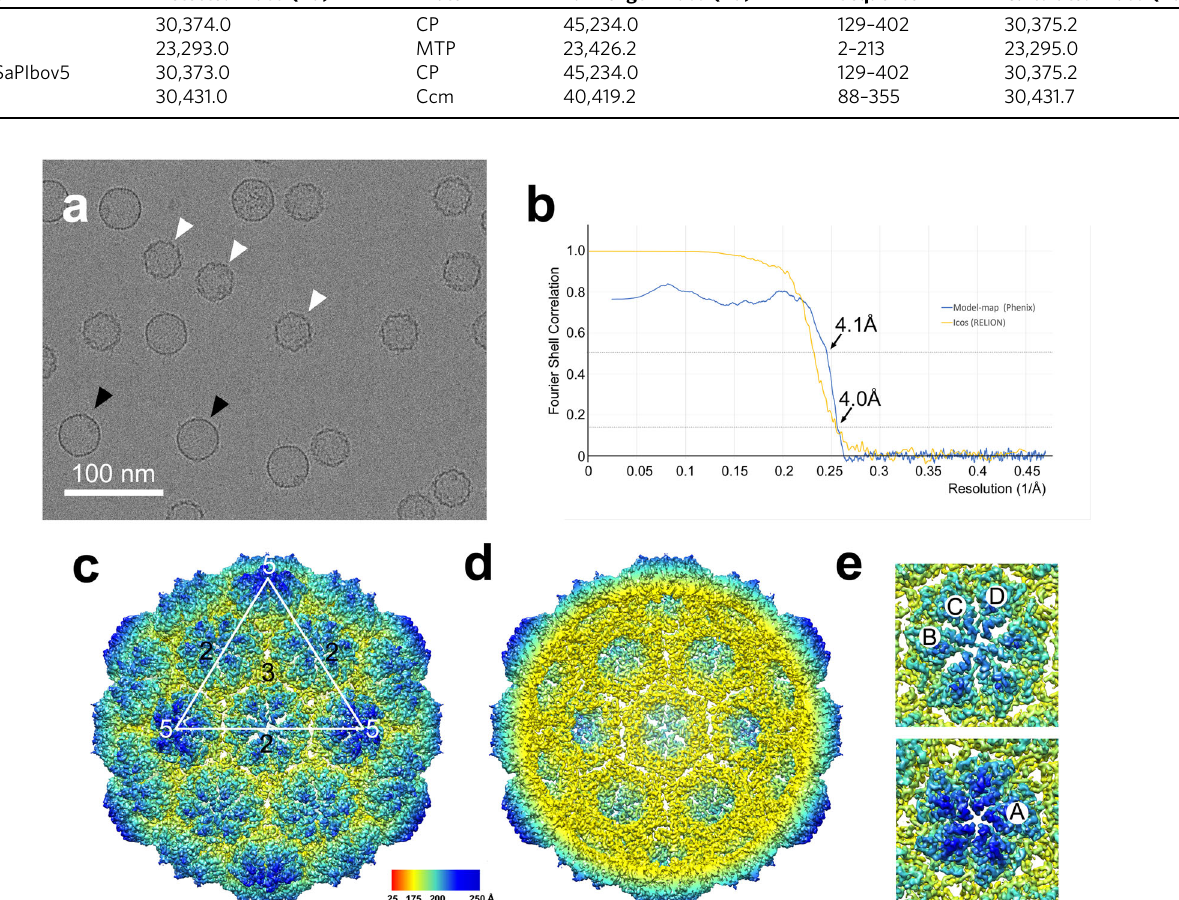
Fig. 4 High-resolution reconstruction of the SaPIbov5 procapsid. a Representative cryo-electron micrograph of capsids formed upon overexpression of Ccm in the presence of ϕ 12 (strain NCH04). Procapsids and expanded capsids are indicated with white and black arrowheads, respectively. Scale bar = 100 nm. b Fourier shell correlation (FSC) curve for the two half-maps of the SaPIbov5 procapsid reconstruction (orange). The resolution at FSC = 0.143 is indicated (4.0 Å). FSC between the map and the model is shown in blue, with the resolution at FSC = 0.5 indicated (4.1 Å). c Isosurface representation of the icosahedral reconstruction of the SaPIbov5 procapsids, rendered at 4 σ , and colored radially according to the color bar. The white triangle represents one icosahedral face, with two-, three-, and fi vefold symmetry axes indicated. d Cutaway view of the SaPIbov5 procapsid reconstruction. e Close-up of hexamer and pentamer with subunits labeled (A –